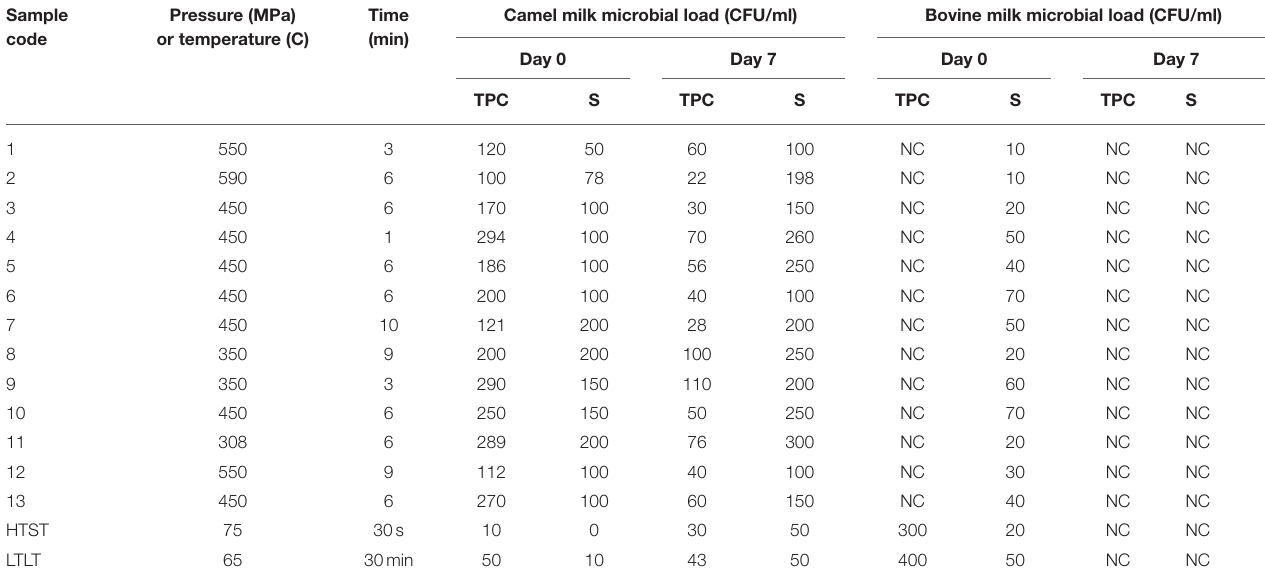
TABLE 4 | Experimental design of the independent variables (pressure, time and at 4 ◦ C) on the associated microbial count of camel and bovine HPP and pasteurization milk. Sample